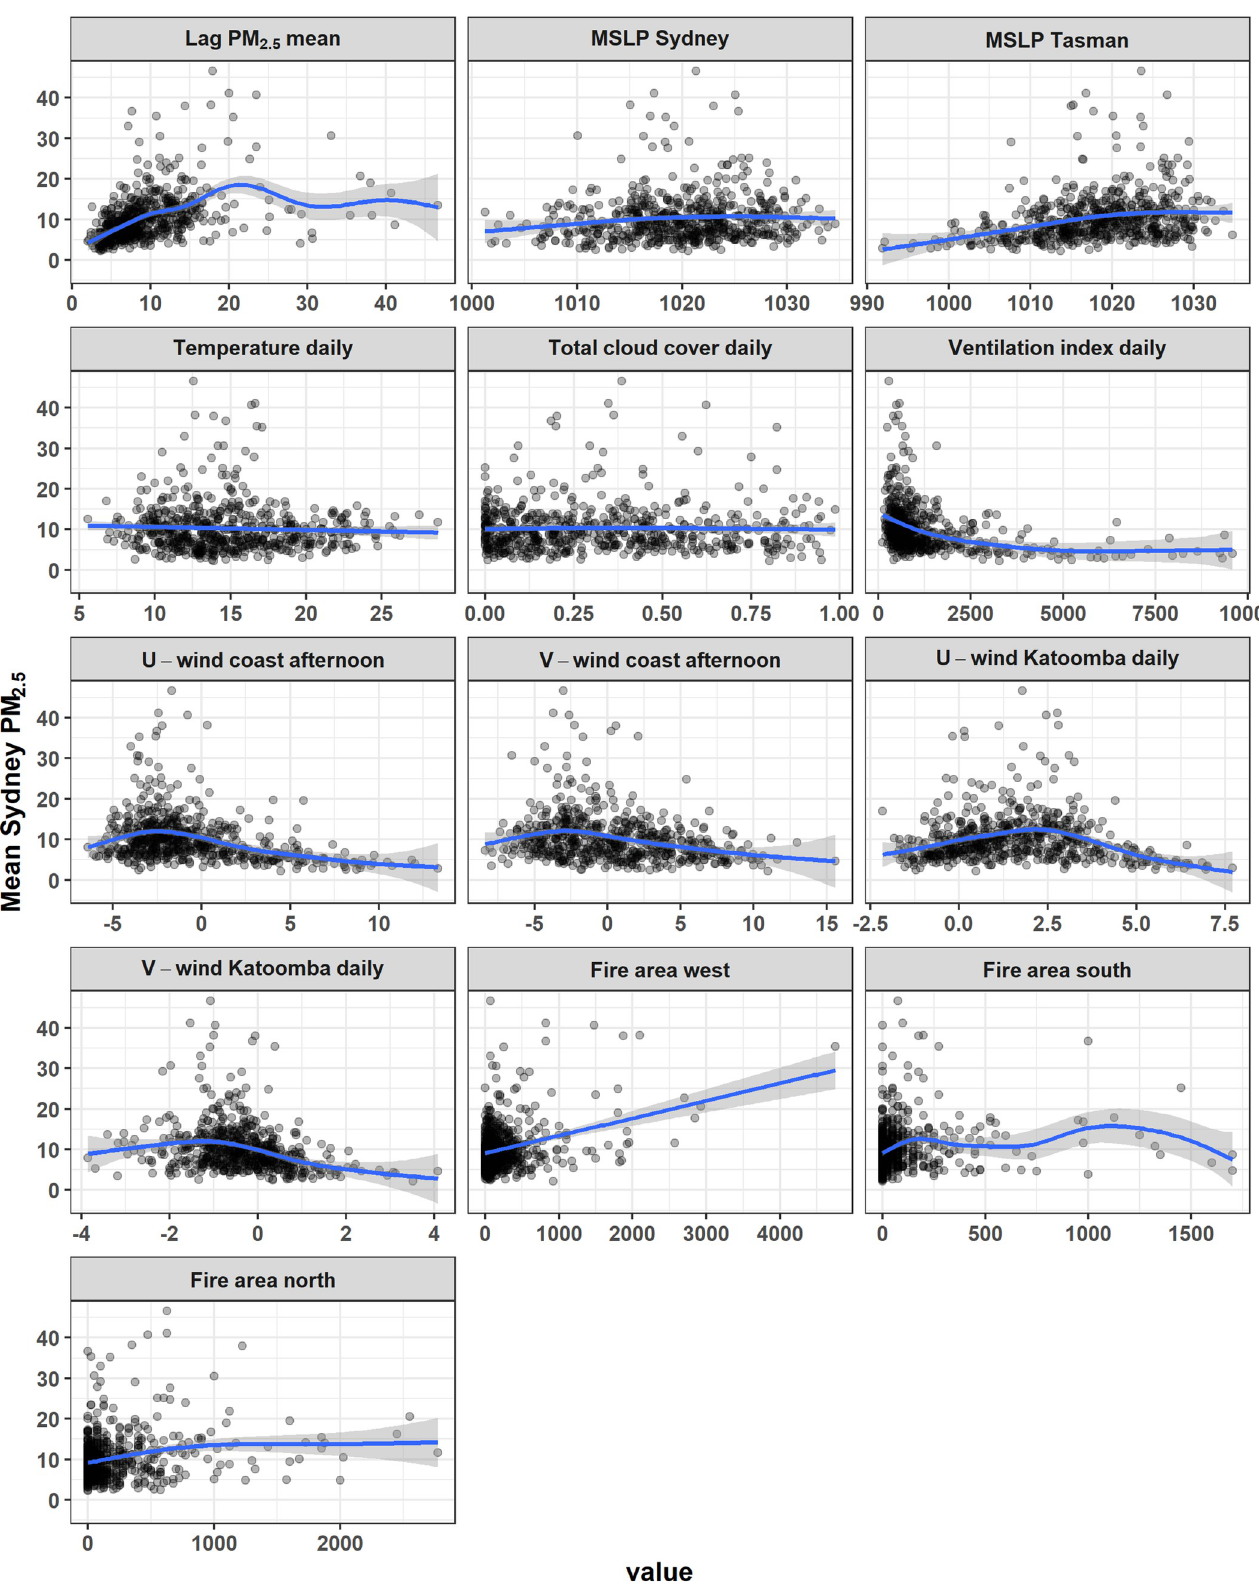
Fig 3. Scatter plots of mean Sydney PM 2.5 vs predictor variables, with single variable GAM smooths fit via the “mgcv” package in R.